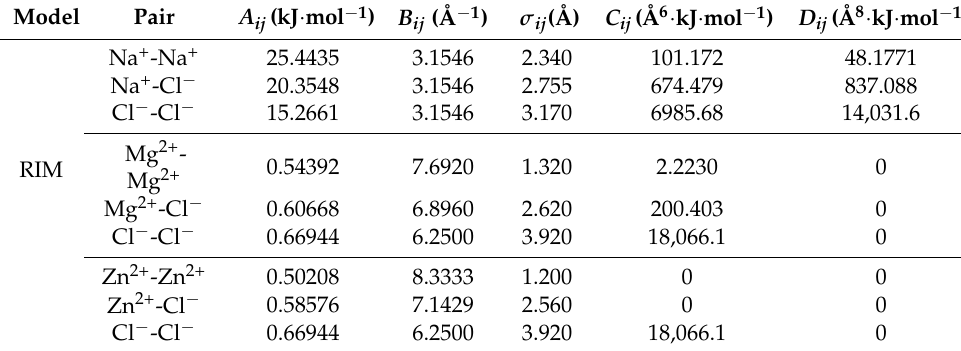
Table 1. Potential parameters of RIM for molten chloride salts.